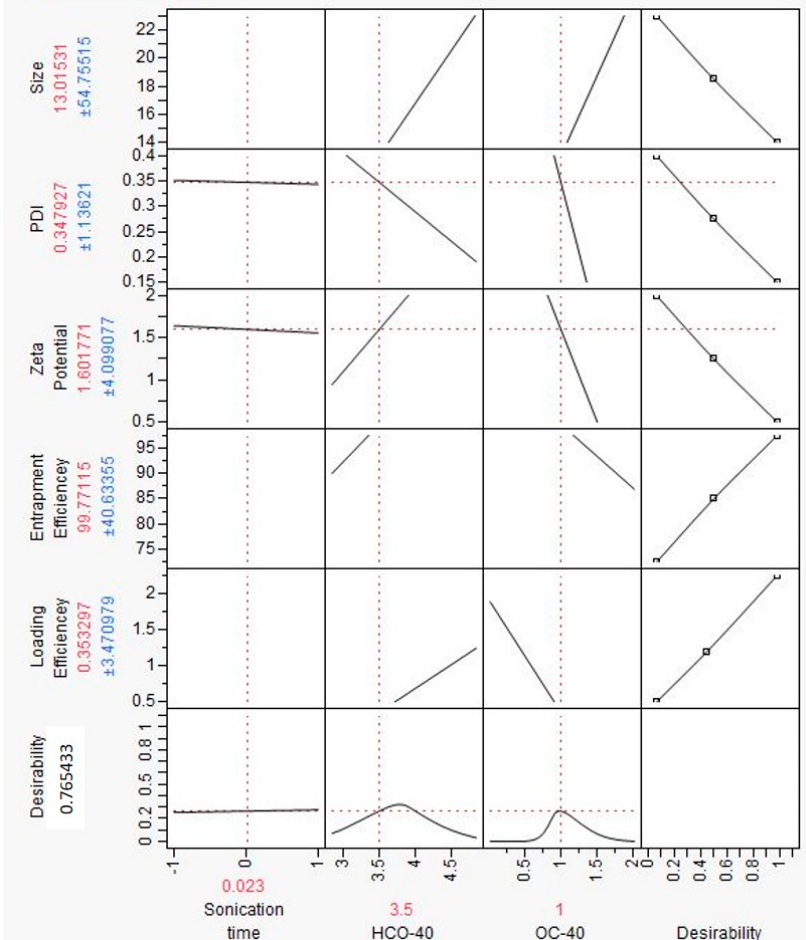
Figure 4. Prediction Profiler for dependent variables such as Size, PDI, Zeta Potential, Loading Efficiency and Entrapment Efficiency depending upon the values of independent variables like polymer concentrations; HCO-40 and OC-40 and sonication time.